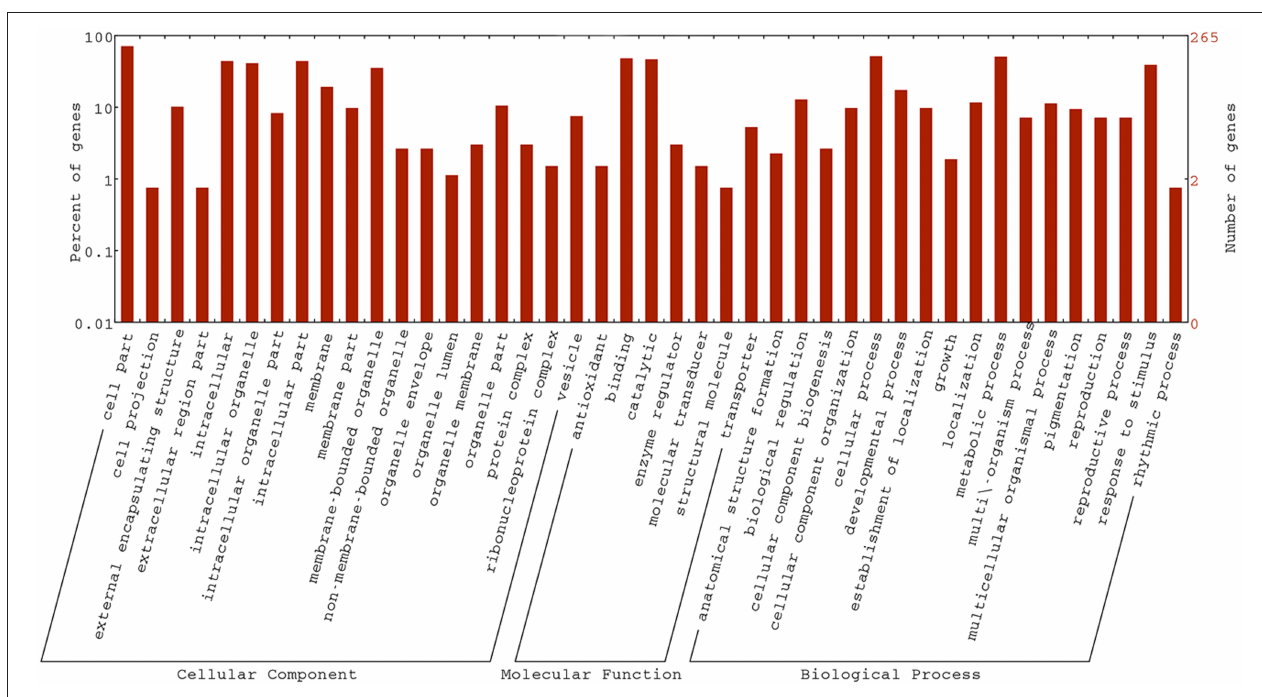
FIGURE 6 | GO classifications of DEGs in drm vs.